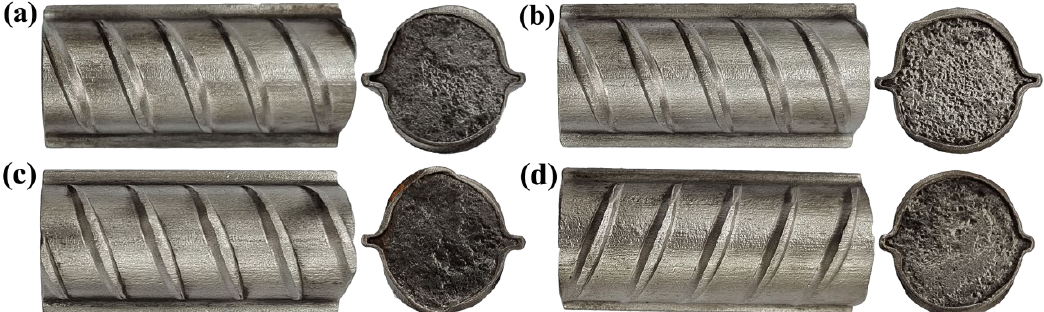
Figure 14. Surface morphologies of various rebars after rust removal: ( a ) 20MnSiV/316L rebar; ( b ) 35#/316L rebar; ( c ) 45#/316L rebar; ( d ) 55#/316L rebar.